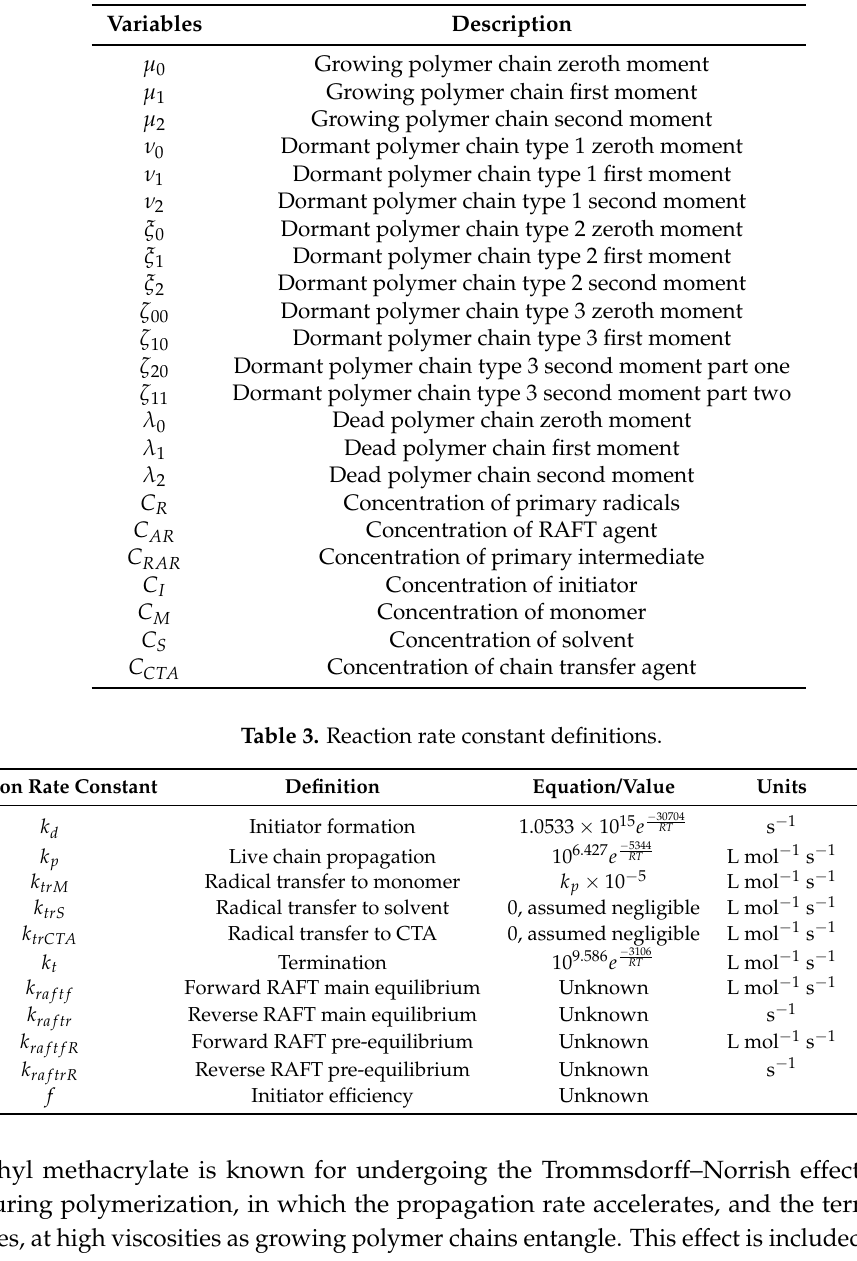
Table 2. State variables.